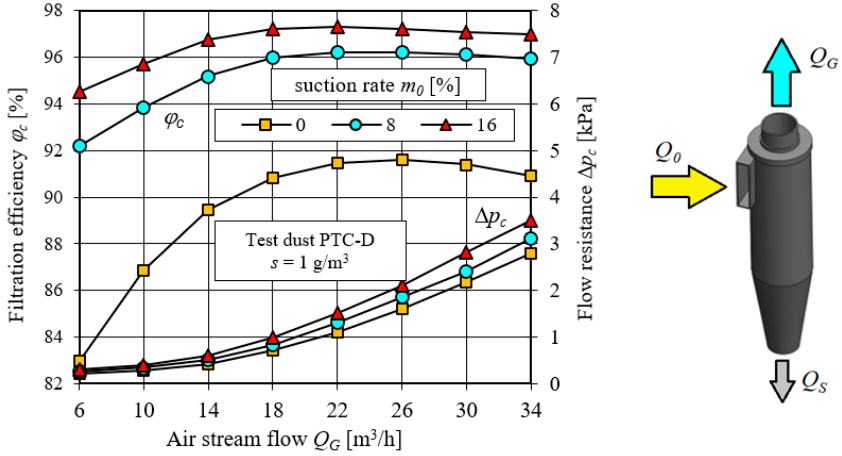
Figure 14. The impact of the suction rate m 0 on the efficiency characteristics ϕ c = f ( Q Gc ) and the flow resistance. ∆ p c = f ( Q Gc ) of the reverse-flow cyclone with the tangential inlet D-40.